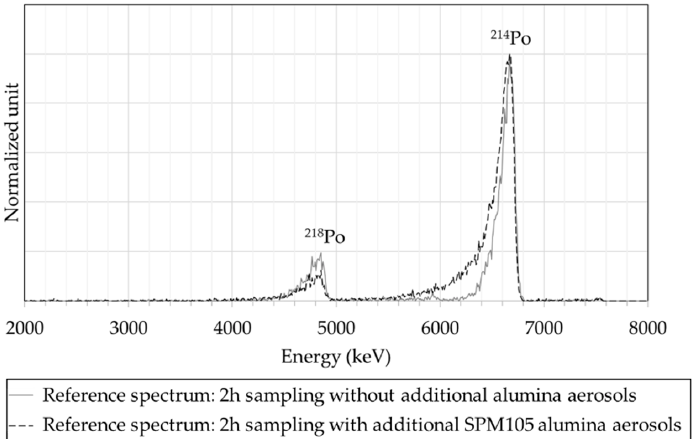
Figure 4. The two reference spectra used in the present paper. Grey-dotted line—a 2 h sampling without additional alumina aerosols in the stable atmosphere of radon; black-dashed line—a 2 h sampling with additional SPM105 alumina aerosols (1.4 mg on the filter) in the same atmosphere.